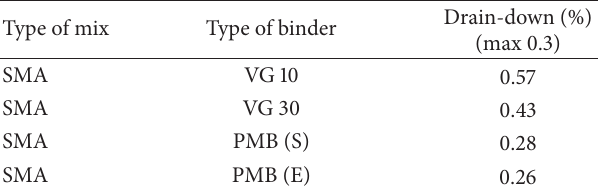
Table 2: Drain-down test